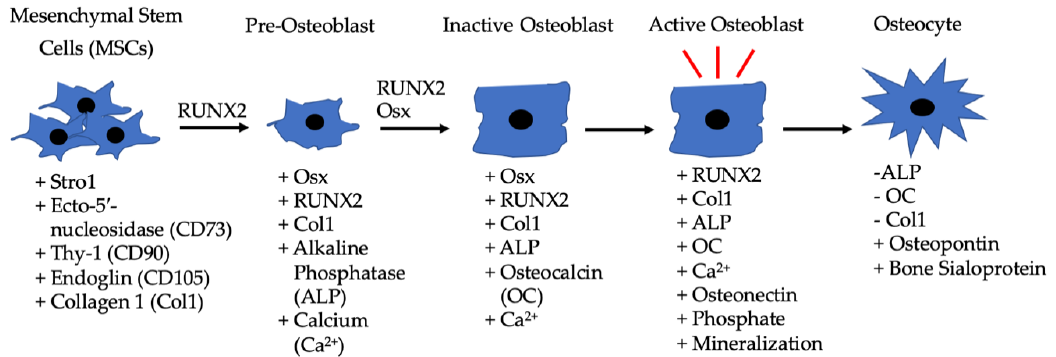
Figure 2. Differentiation of MSCs to osteoblasts driven by BMP-2, along with the other listed factors. MSCs are located in bone marrow and differentiate into pre-osteoblasts when exposed to RUNX2 and BMP-2. The pre-osteoblasts differentiate into inactive osteoblasts in the presence of RUNX2, BMP-2, and Osx. Inactive osteoblasts become active osteoblasts in bone microenvironments that require rebuilding, and BMP-2 can also assist in this process. Active osteoblasts can then become embedded in bone and function as osteocytes.